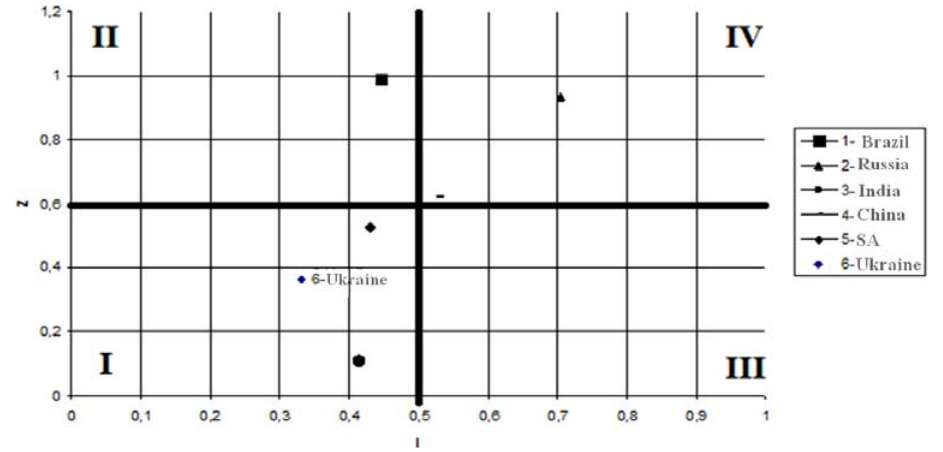
Fig. 3. Strategic positioning of Ukraine and member countries of BRICS in the second year of forecast